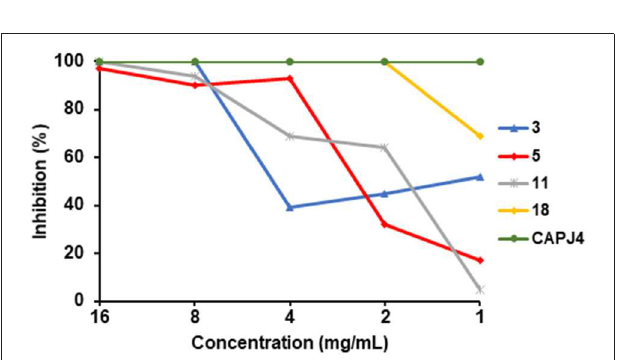
FIGURE 8 | Inhibition of C. pseudotuberculosis biofilm formation by green propolis extract. Four C. pseudotuberculosis clinical isolates and the CAPJ4 biofilm producing strain were incubated with different green propolis extracts concentrations for 48h, and biofilm was then quantified. Each line represents the results of an individual C. pseudotuberculosis biofilm-producing strain. Results are expressed as means of three independent experiments.